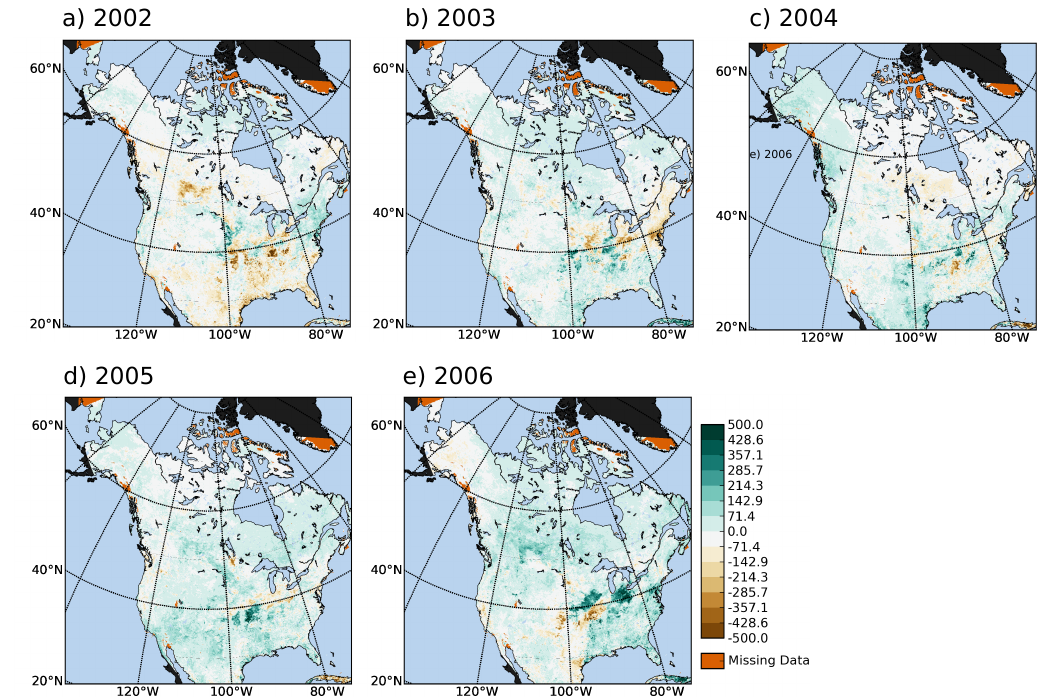
Fig. 10. Annual anomaly, annual integrated VPRM GEE, calculated using PFT–all-data VPRM parameters. Units are gCm − 2 yr − 1 . Anoma- lies are calculated as annual integrated VPRM GEE minus the 2002–2006 mean annual integrated VPRM GEE. Thus negative values denote lesser than average atmosphere to ecosystem CO 2 flux. Black areas are outside of the study domain.